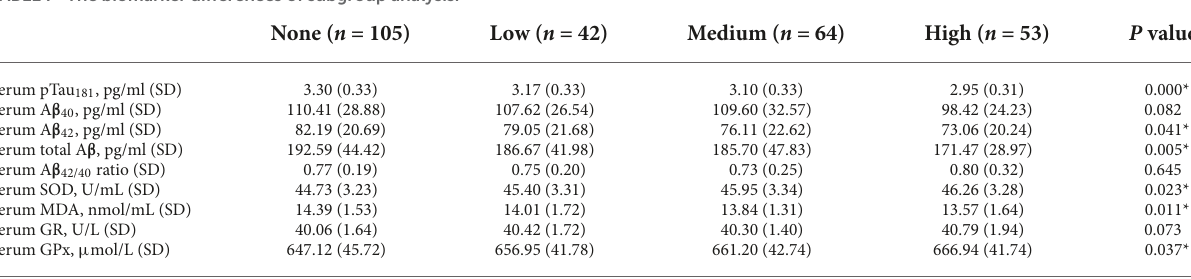
TABLE 7 The biomarker differences of subgroup